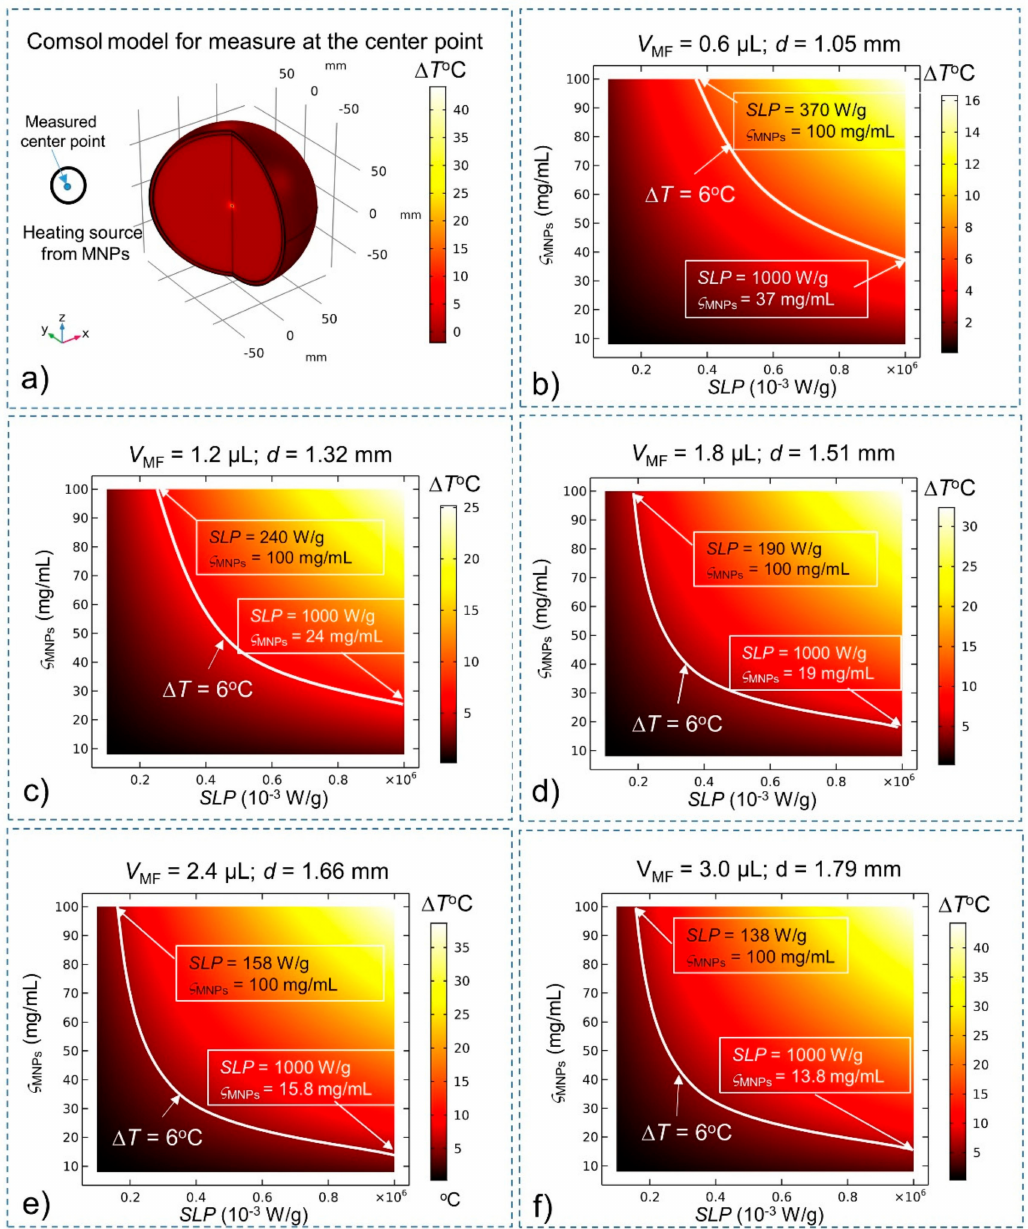
Figure 3. Steady-state temperature at the center of the stimulation region obtained using the bio-heat equation as a function of the SLP, concentration ( ς MNPs ) and volume ( V MF ) of MNPs. Conditions that satisfy the temperature increase ∆ T > 6 ◦ C lie above the white curve ( ∆ T = 6 ◦ C). ( a ) Comsol Multiphysics model for measuring temperature at the center of the stimulation region; ( b ) V MF = 0.6 µ L; ( c ) V MF = 1.2 µ L; ( d ) V MF = 1.8 µ L; ( e ) V MF = 2.4 µ L; and ( f ) V MF = 3.0 µ